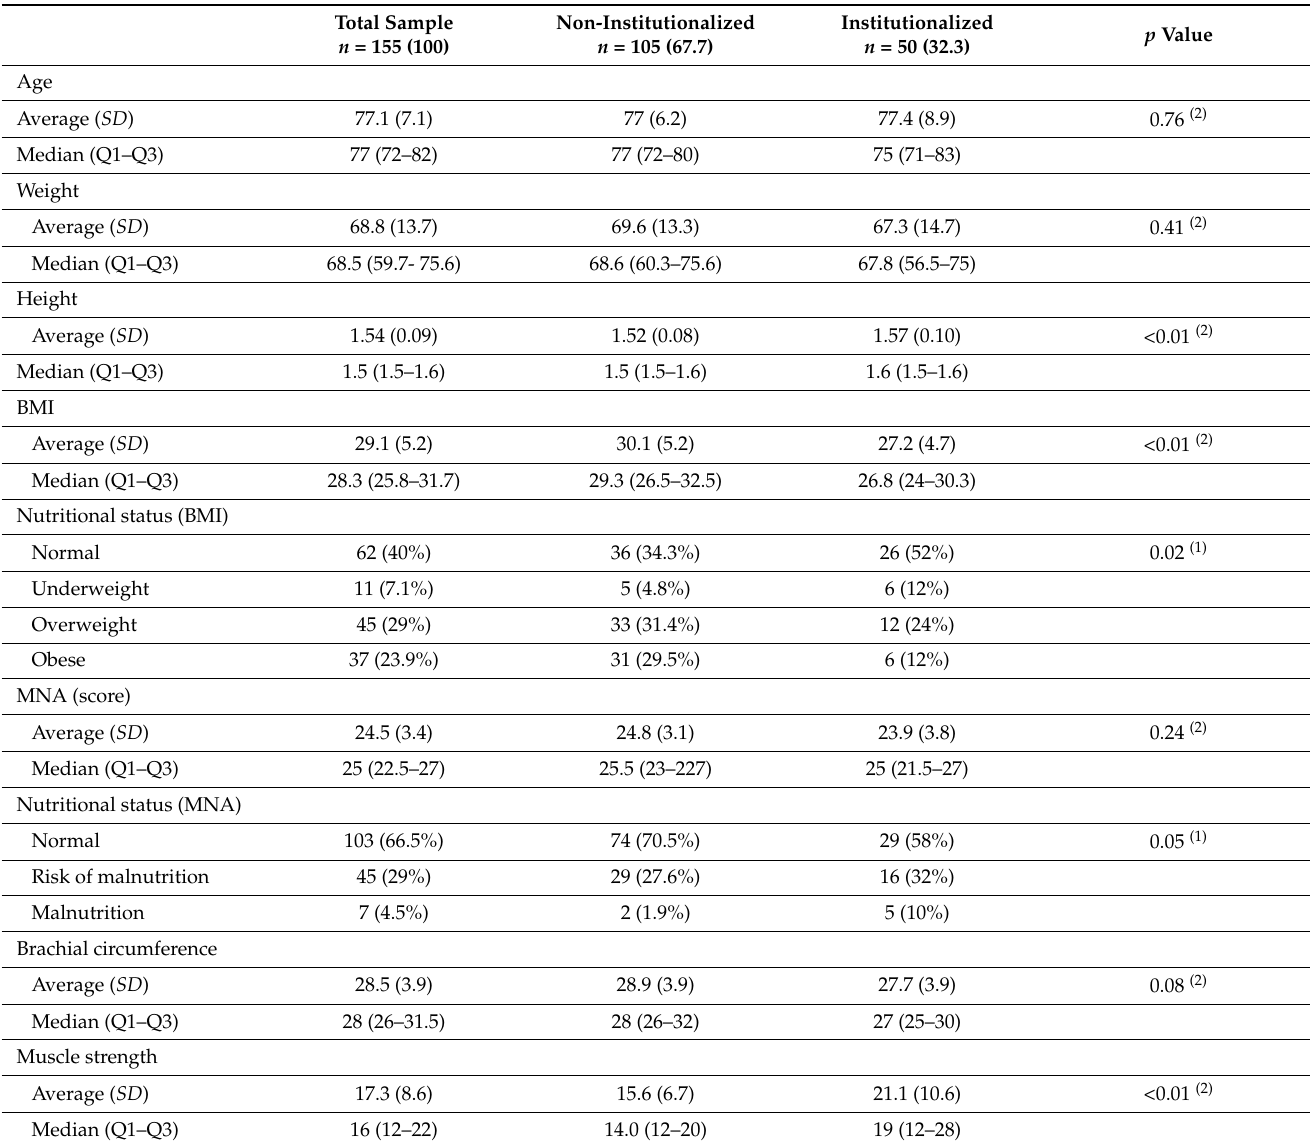
Table 2. Characteristics of the sample according to type of